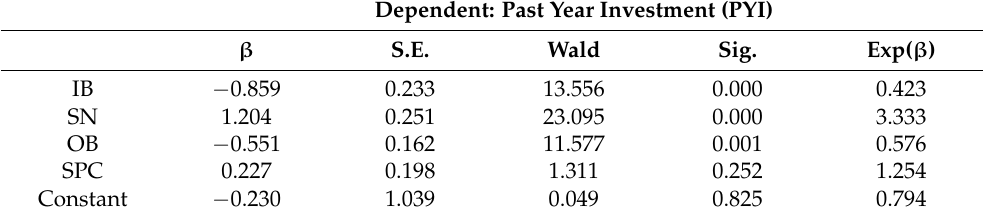
Table 6. Coefficient of Predictor Factors.